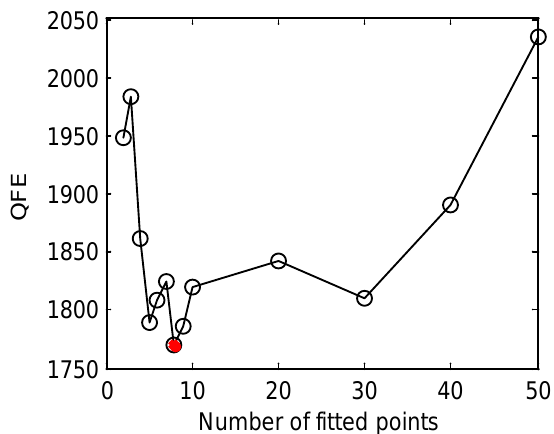
Figure 5. Fault diagnosis of fault 7 with linear fitted initial values.